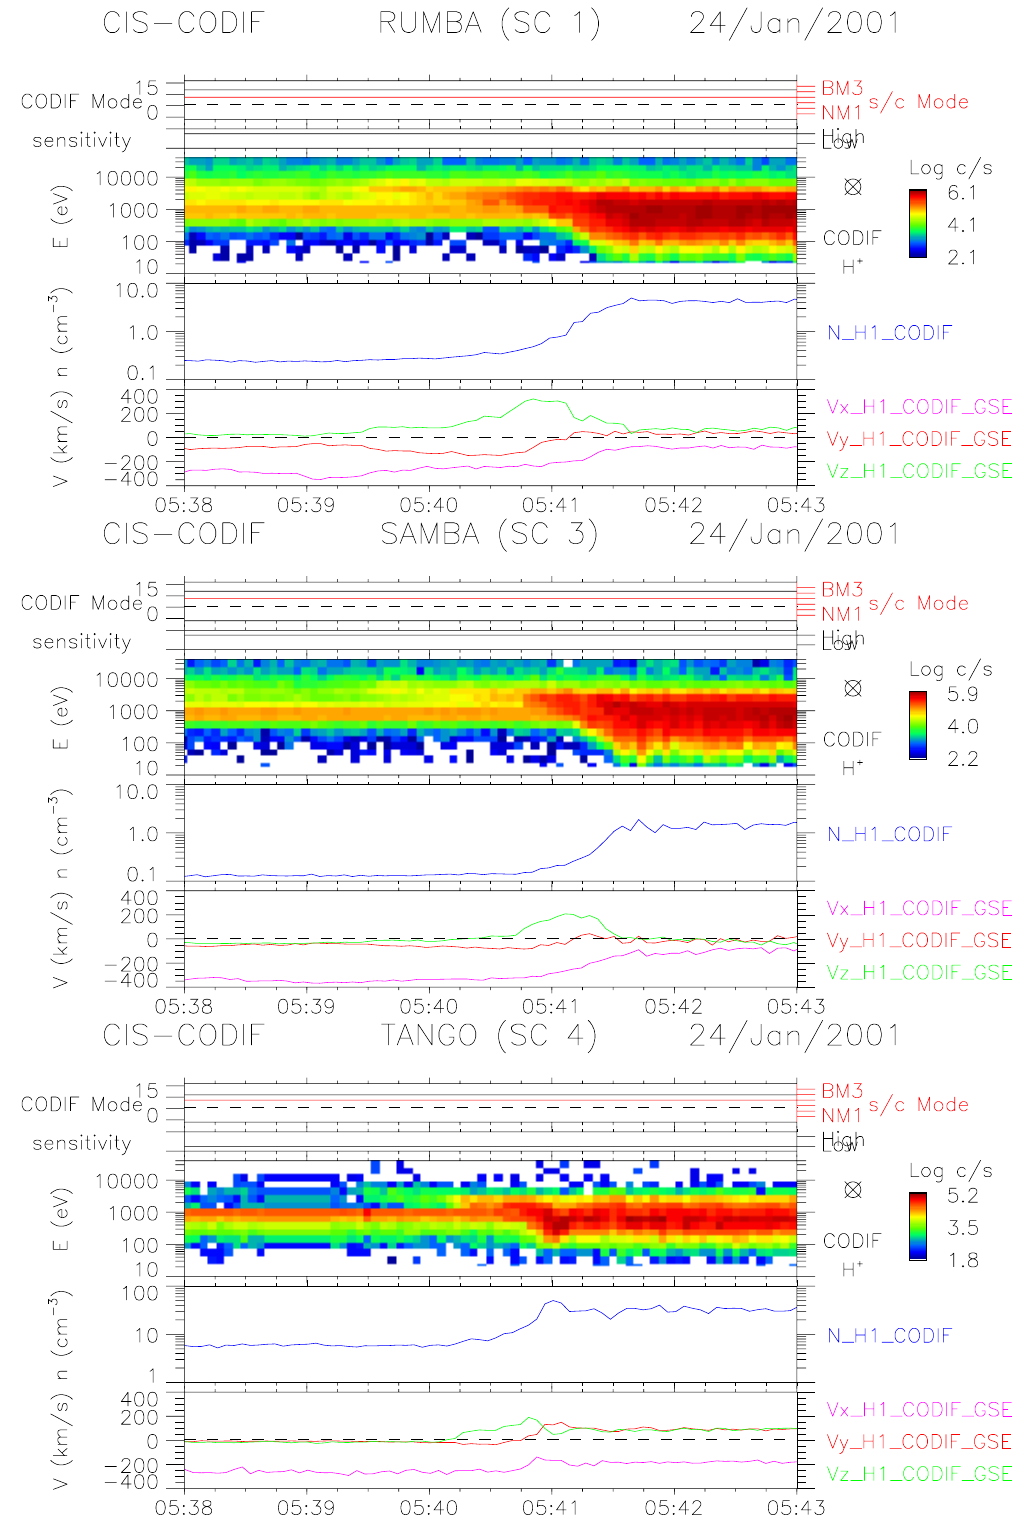
Fig. 31. Entry in the magnetosheath of spacecraft 1, 3, and 4 on 24 January 2001, between 05:38 and 05:43UT as seen by CODIF. The three panels show CODIF telemetry modes and sensitivities, energy-time spectrogram integrated over 4 5 , density and GSE velocity components. Note that on spacecraft 4 (lower panel), CODIF is used in low sensitivity mode and the density is correct, while on spacecraft 1 (upper panel) and spacecraft 3 (middle panel), CODIF is used in high sensitivity mode and the measured densities are not correct due to saturation